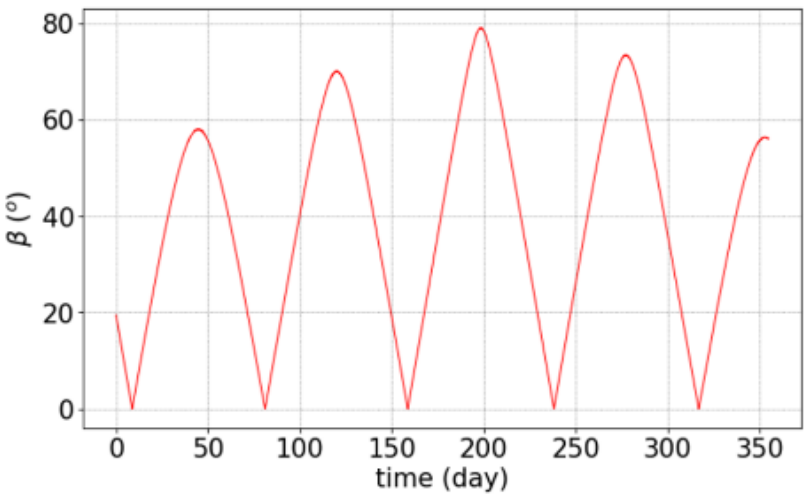
Figure 5. Angle between the sun and the SWOT orbit plane (also known as beta angle) as a function of time over one year.